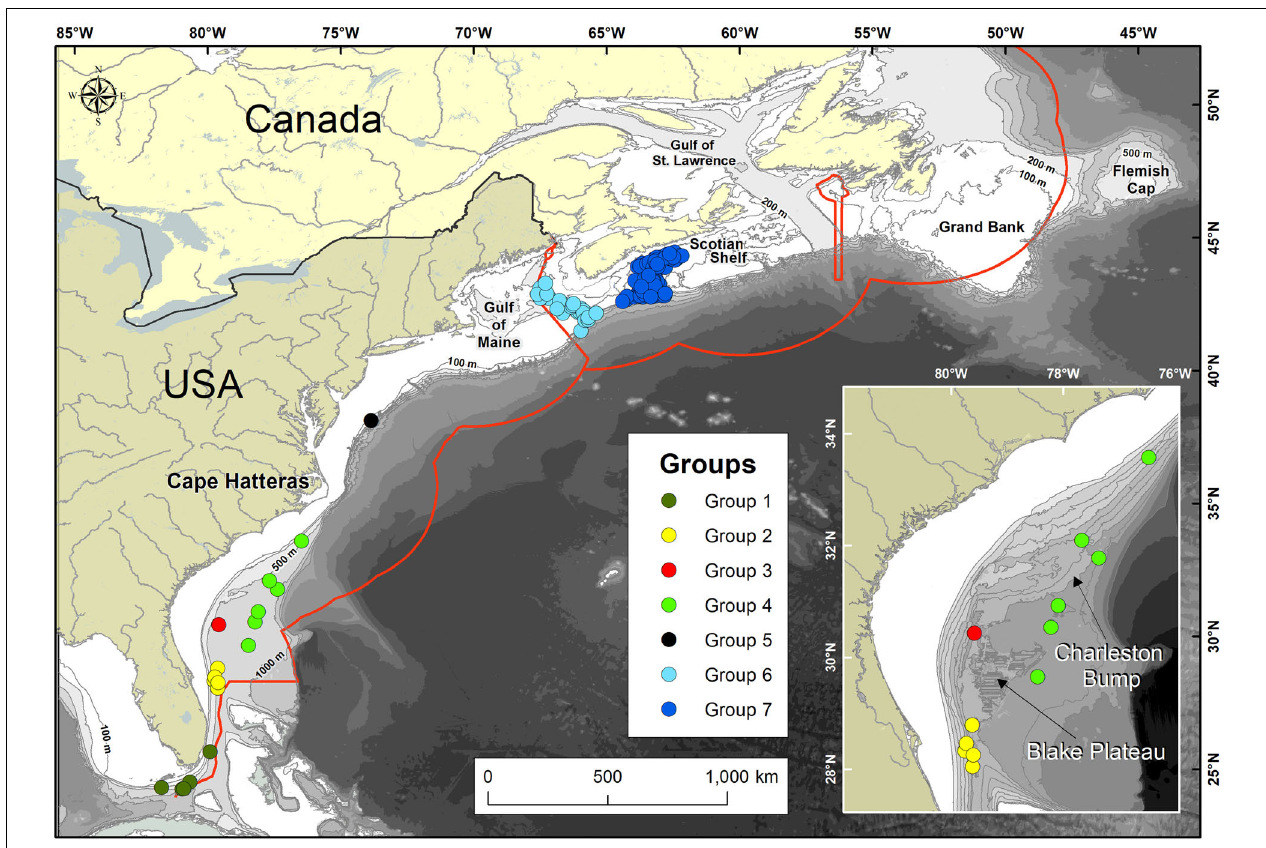
FIGURE 1 | Place names and locations of confirmed occurrences of V. pourtalesii along the eastern coast of North America. Occurrences are colour-coded by their assigned Group (1–7). The inset shows the area of the Blake Plateau with the location of the Charleston Bump. Red line indicates the exclusive economic zones of the United States, Canada, and France (with respect to Saint Pierre and Miquelon). Additional place names, general position of major currents and water masses, topography, and undersea features in the study area are provided in Figure 2